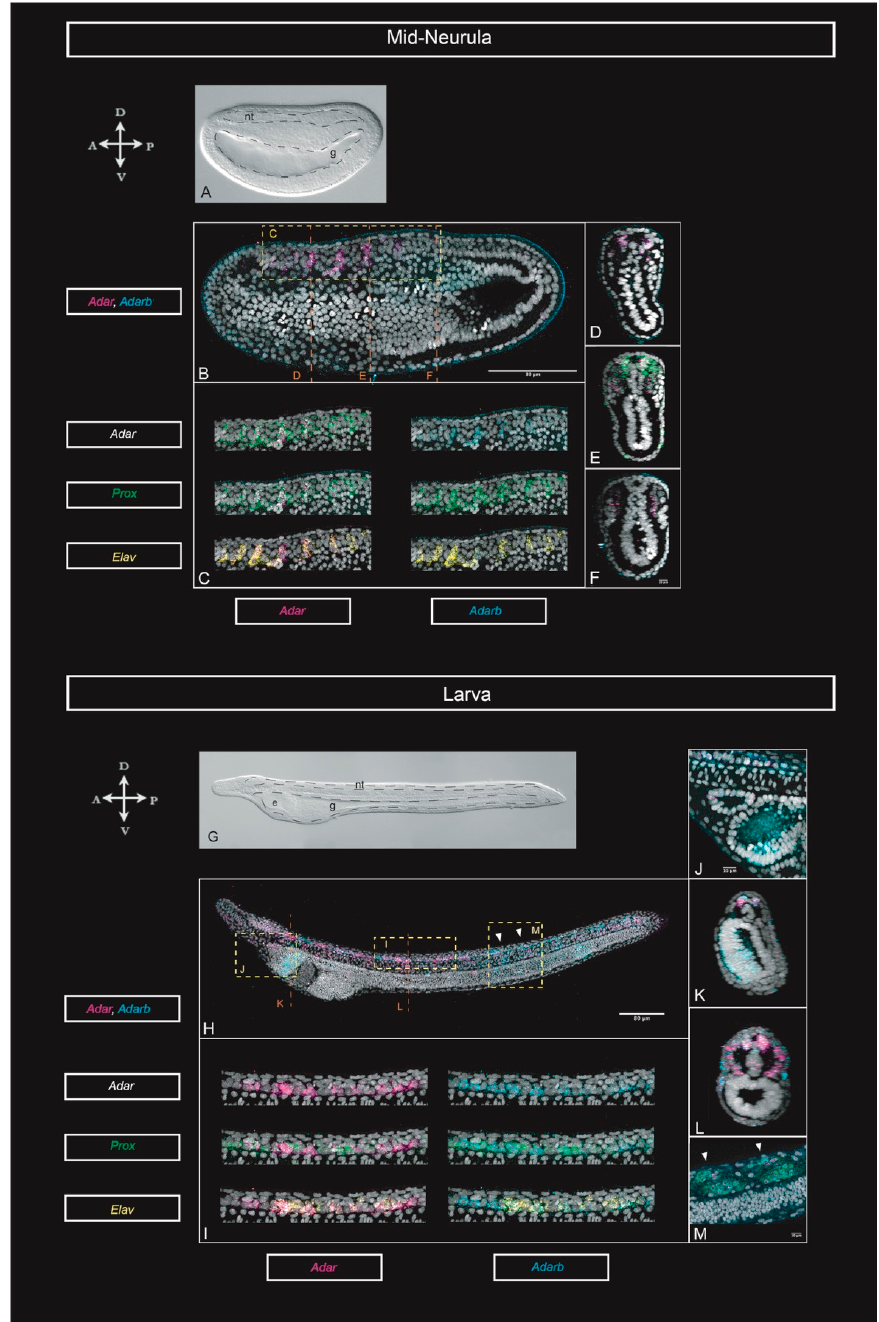
Figure 2. Adar, Adarb, Elav, and Prox1 expression through development. ( A ) Bright field and ( B ) maximum projection for Adar and Adarb , from quadruple HCR (hybridization chain reaction) in situ hybridizations at the mid-neurula (18 hpf) stage. ( C ) Magnified view from D in B showing the co-expression of Adar , Adarb , Prox, and Elav in the neural tube of the mid-neurula. ( D ) Cross section at the level of C in B, showing expression of Adar and Adarb in the neural tube. ( E ) Cross section at the level of E in B, showing expression of co-expression of Adar and Prox in the neural tube and somites. ( F ) Cross section at the level of F in B, showing expression of Adar and Adarb in somites. ( G ) Bright field and ( H ) maximum projection for Adar and Adarb , from quadruple HCR in situ hybridizations at